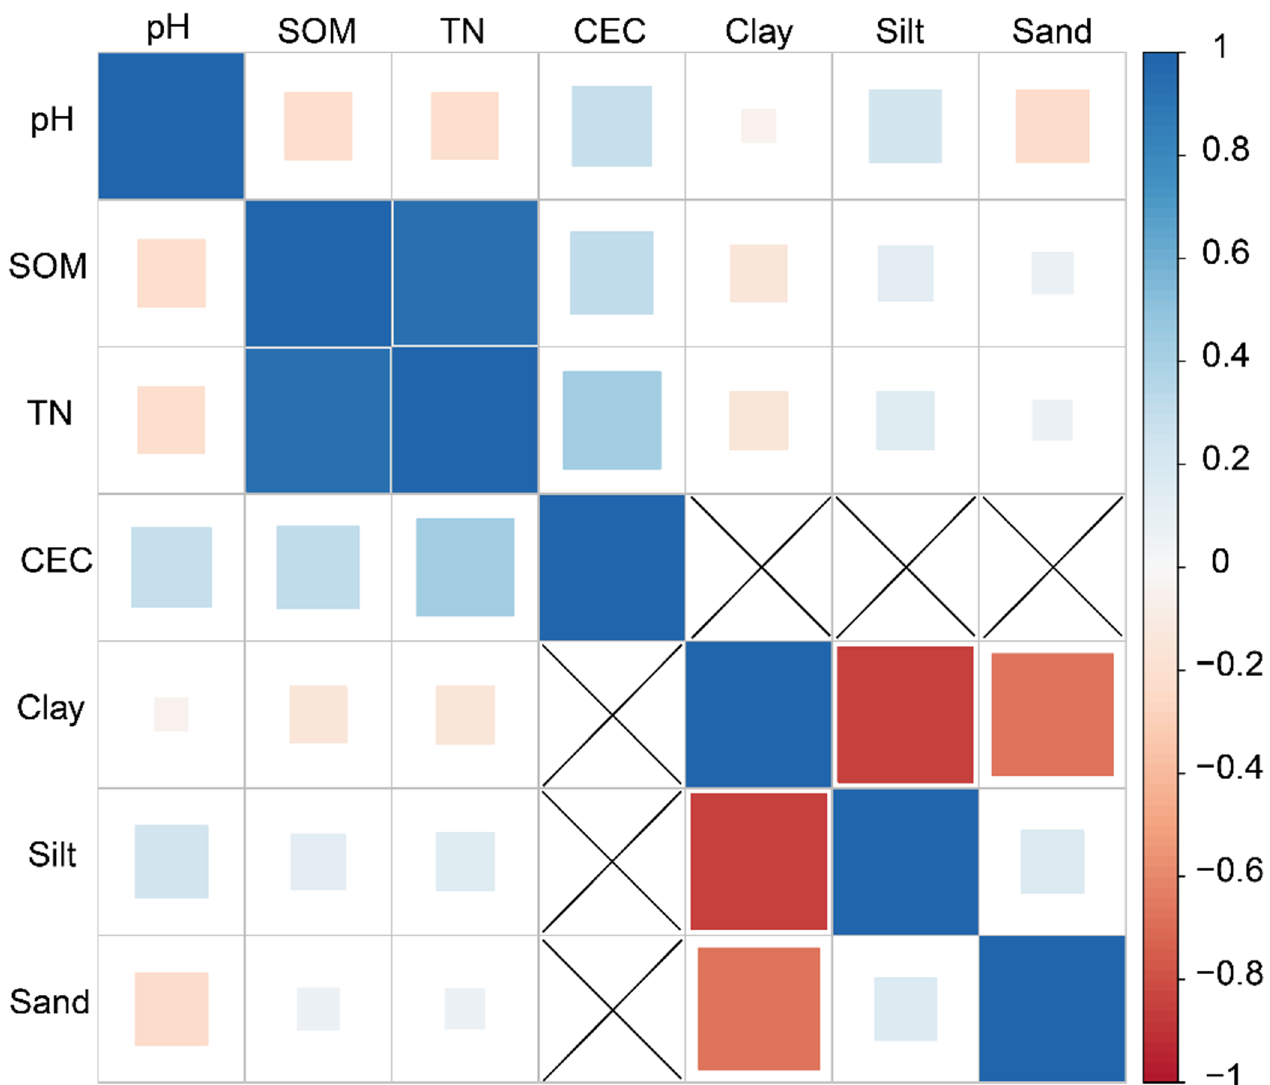
Figure 2. The location of the study area and soil sampling sites. The black cross indicates that the correlation between predictors is not available.